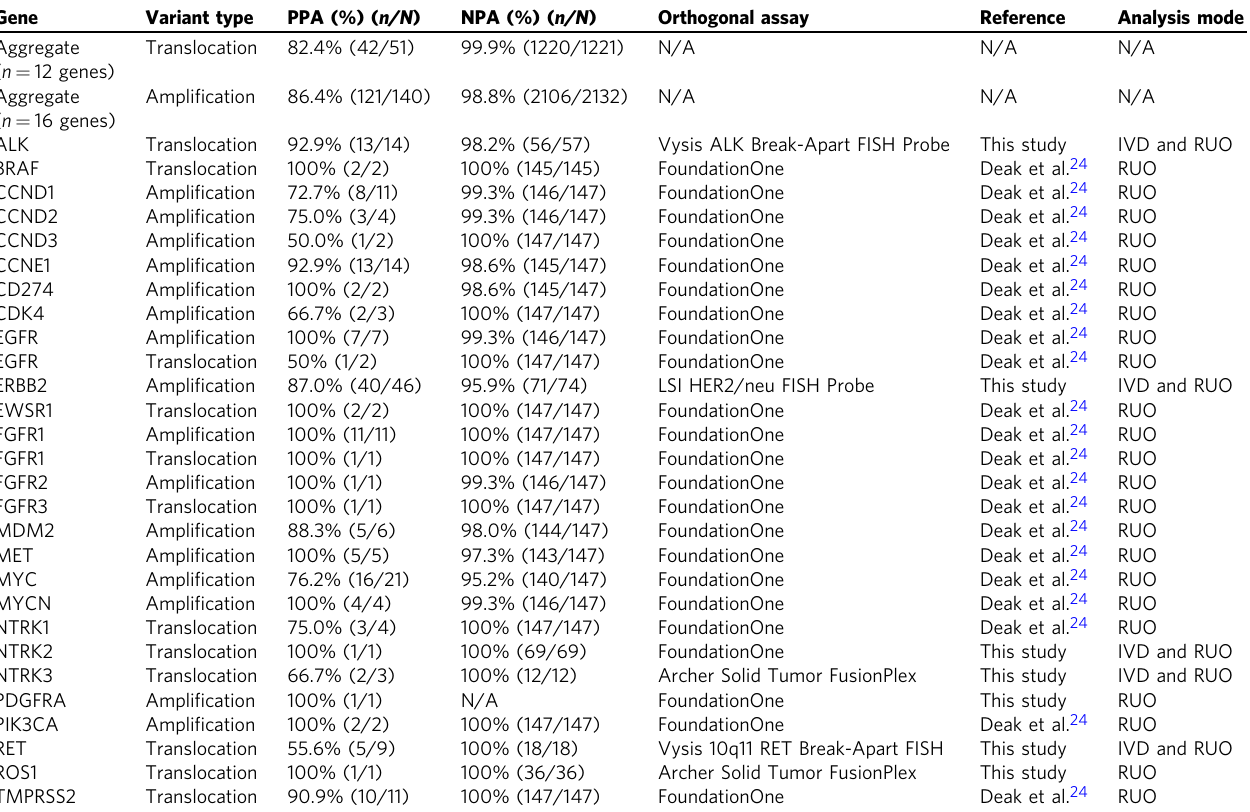
Table 1 Summary of ampli fi cation and translocation detection analytical